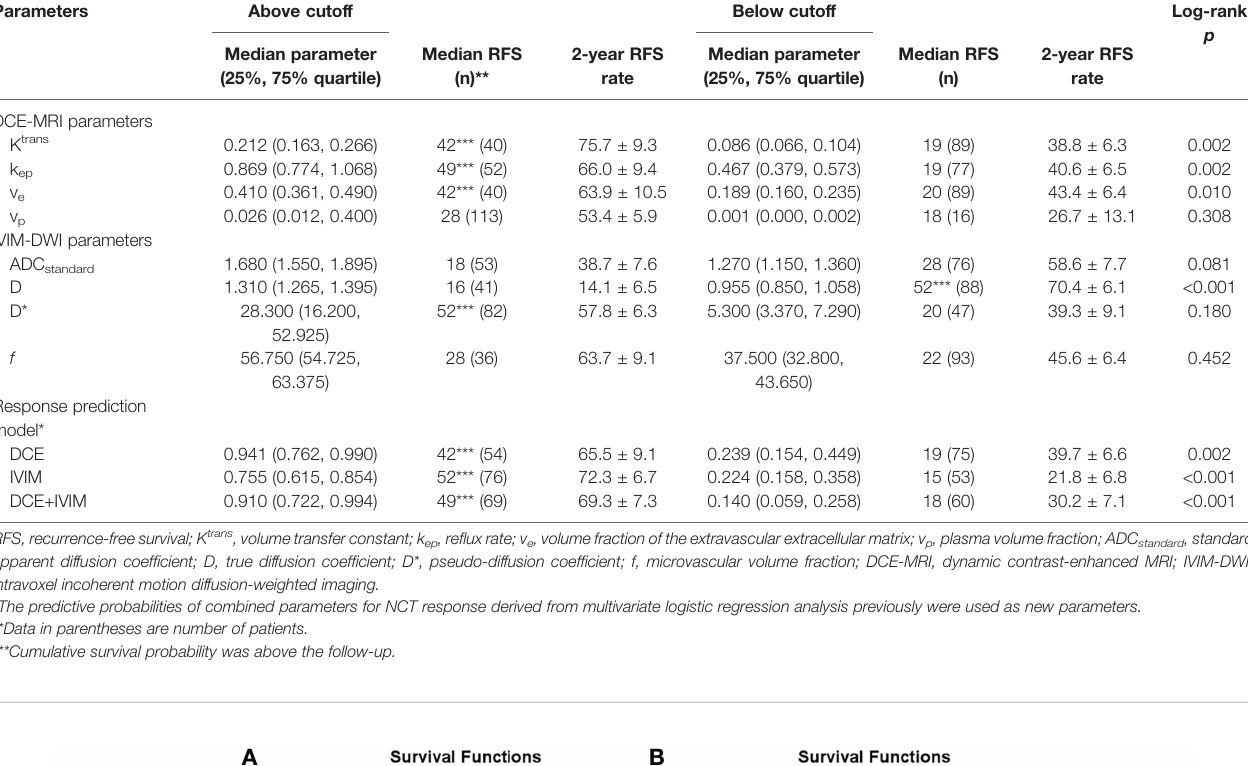
TABLE 7 | Kaplan – Meier survival analysis according to cutoff values for predictors of RFS. Parameters